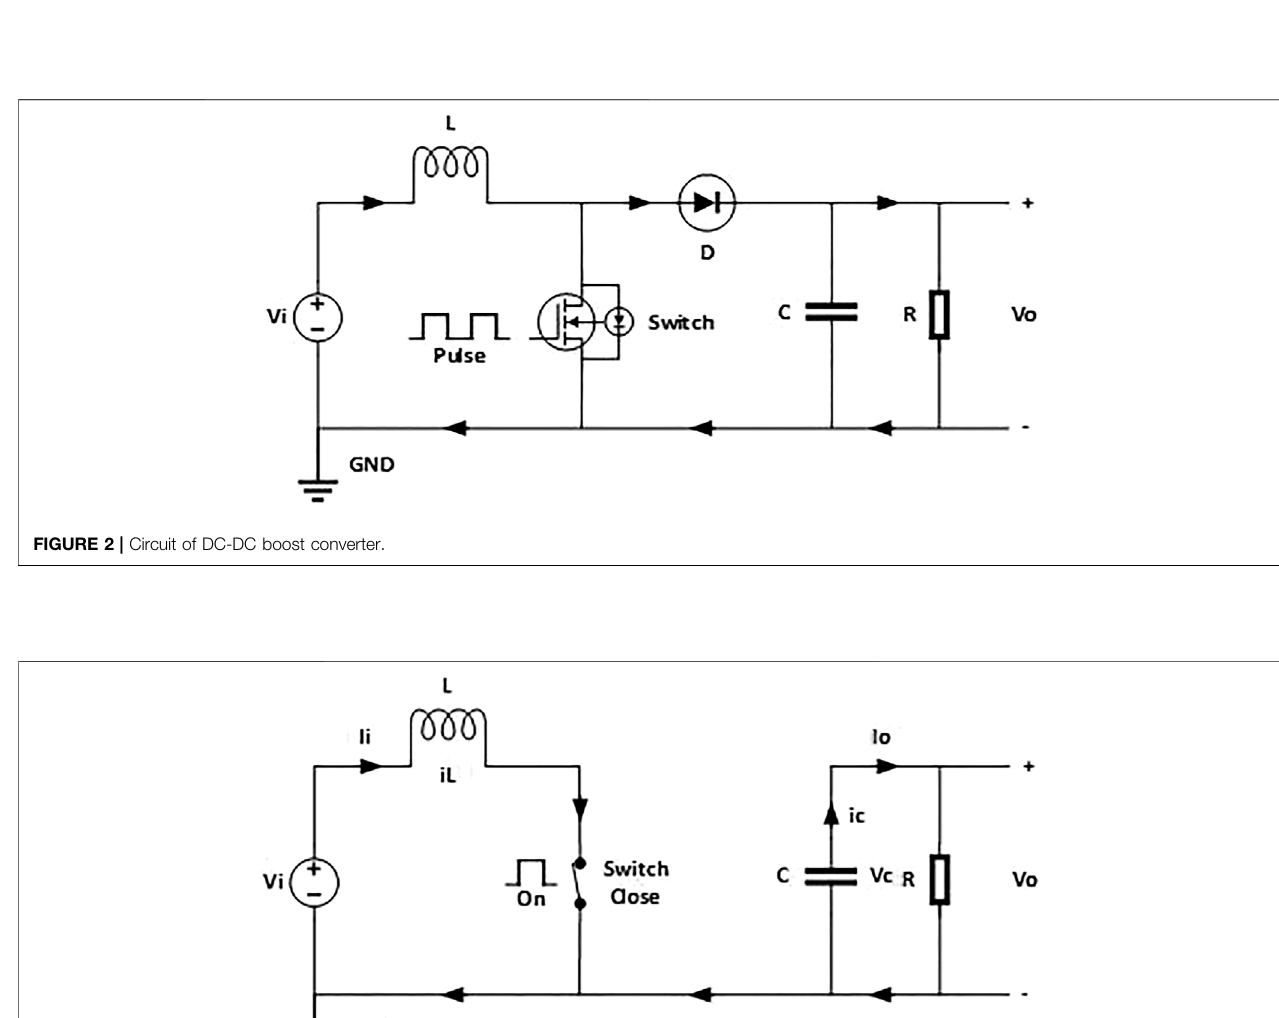
FIGURE 3 | Circuit of DC-DC in closed-switch